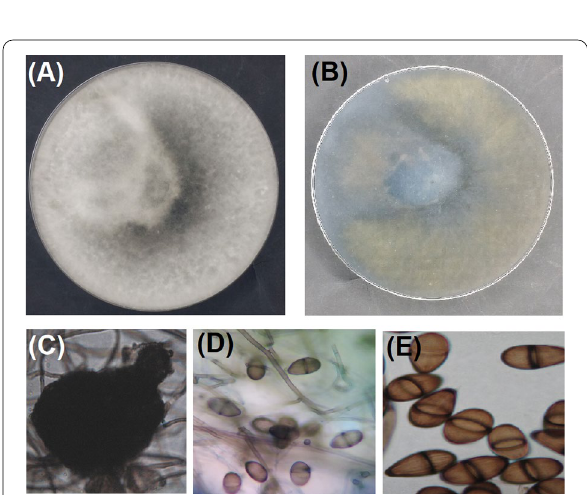
Fig. 2 Morphological characteristics of L. theobromae AUMC14508. A Front colony view. B Reverse colony view. C–E Microscopic appearance